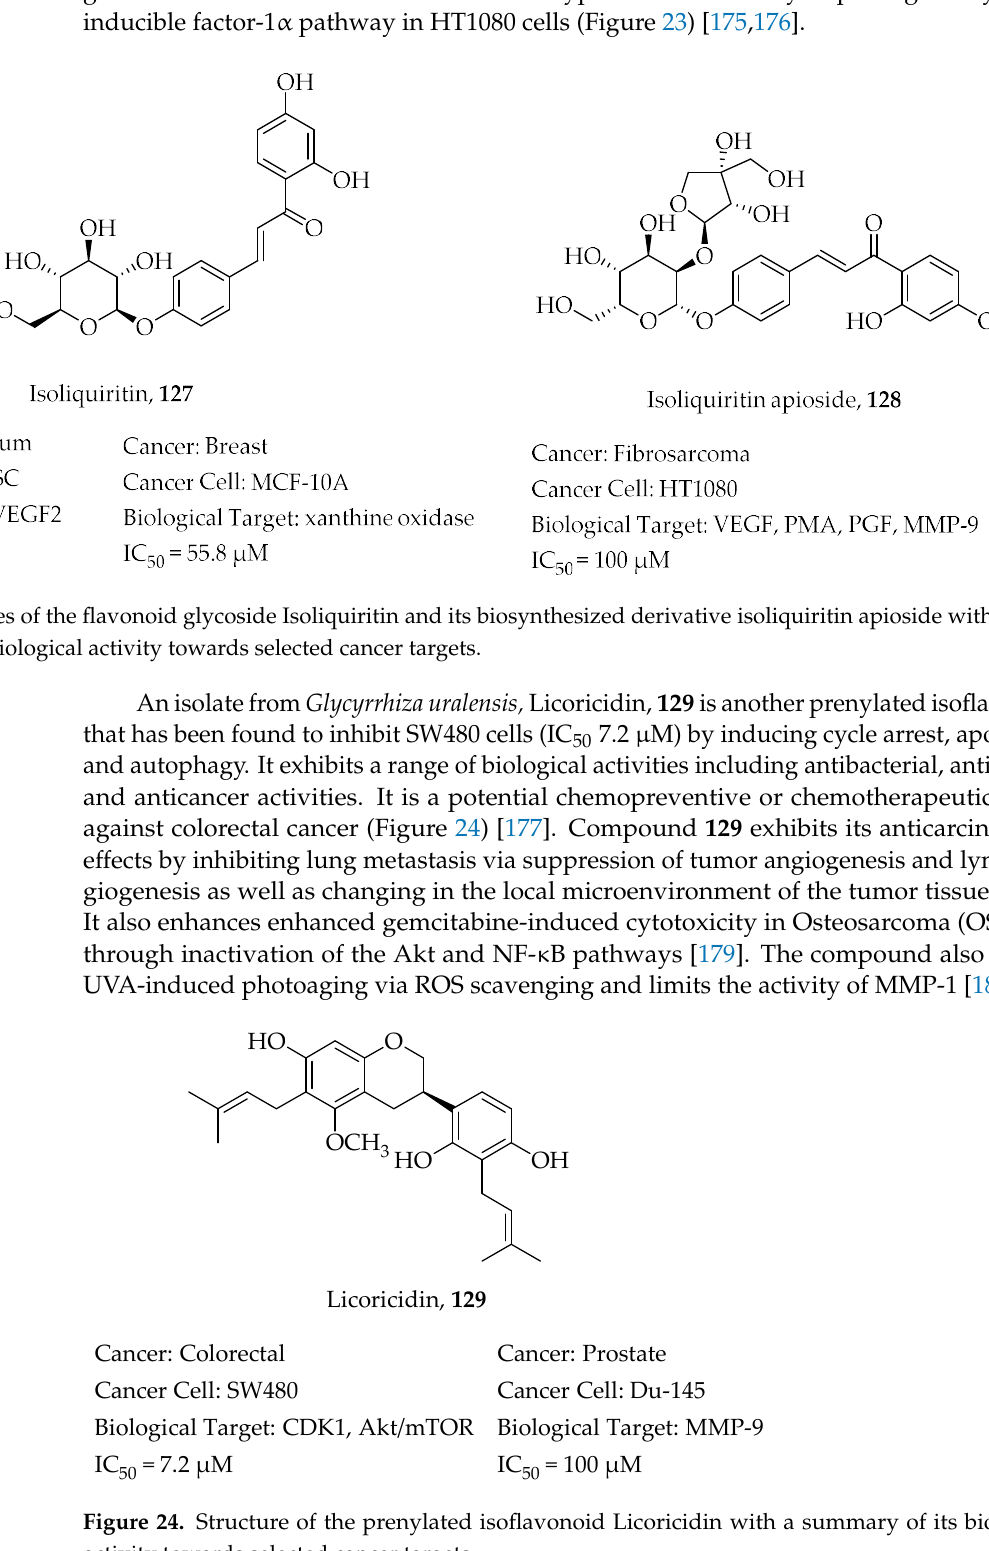
24 of 50 Figure 22. Structure of an isoflavonoid Glabridin with a summary of its biological activity towards selected cancer targets.